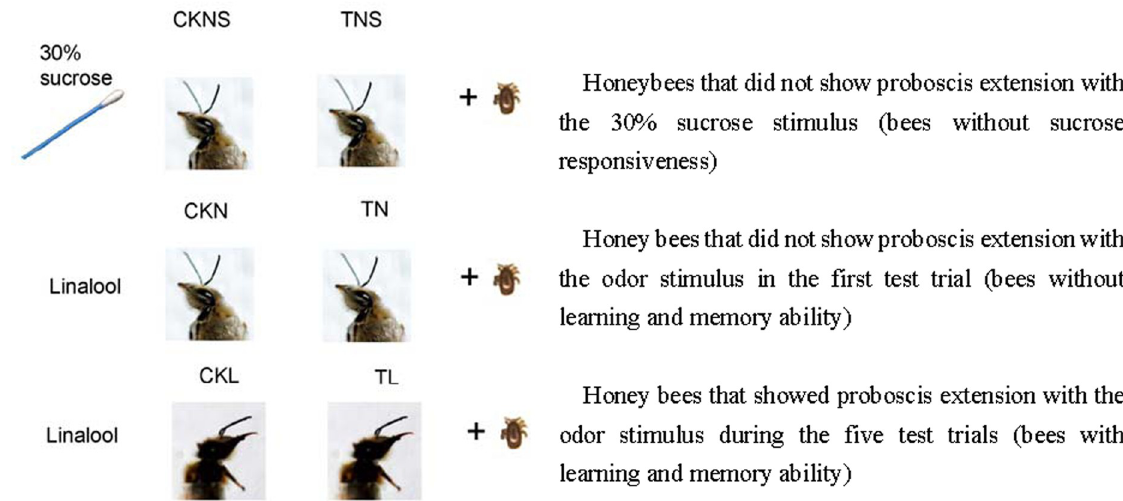
Fig 4. Schematic of RNA-seq experimental design. The experimental design consisted of three groups displaying different sucrose responsiveness or learning ability.